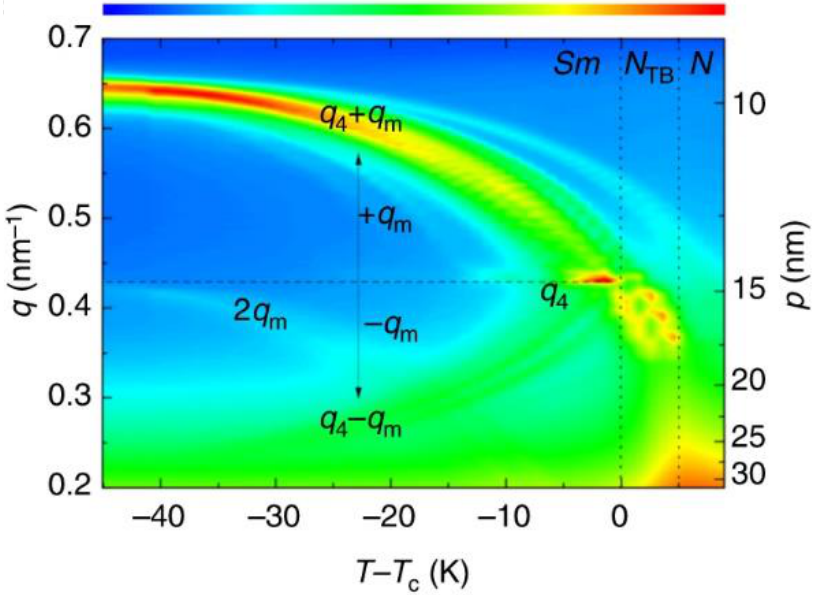
Figure 18. The resonant soft-X-ray scattering pattern for CB6O.10 (taken from [94]).